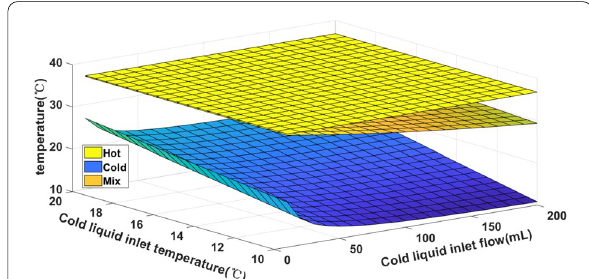
Figure 13 Output temperature trend curves influenced by input flow and temperature during